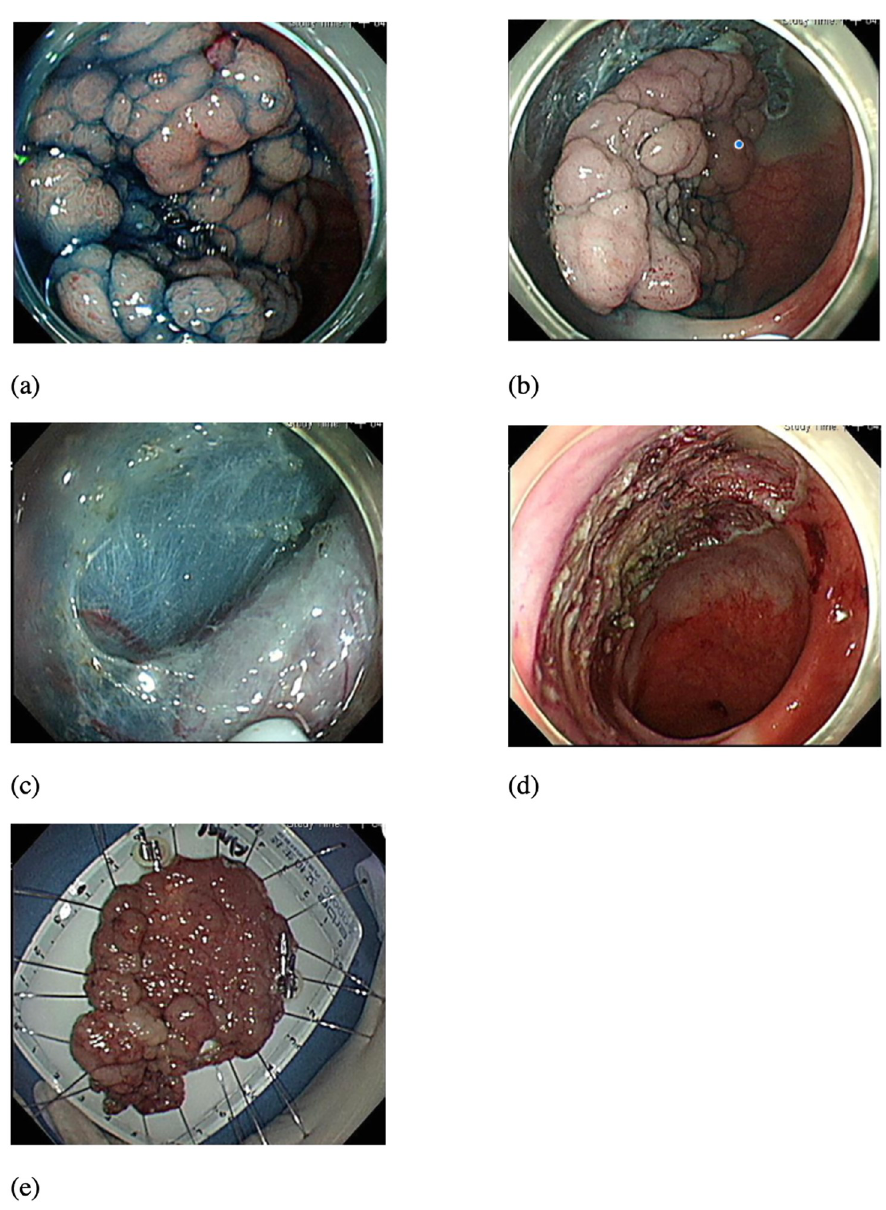
Fig 1. Colorectal ESD procedure. (a) Chromoendoscopy with indigo carmine staining (b) Circumferential cutting (c) Submucosal dissection (d) Complete resection (e) Specimen fixation. Therapeutic and histopathological results of ESD for colorectal neoplasms The ESD time was 51.9 ± 32.9 minutes (Table 2). Forty of 244 lesions (16.4%) were completed with hybrid ESD. Nine cases (3.7%) had procedure-related complications, including two mini- mal perforations (0.8%) closed by SureClip 1 successfully after the complete ESD procedure and 7 delayed bleeding (2.9%). Our minimal perforation was defined as muscle layer defect without observation of mesenteric fat or intra-peritoneum organ and pneumoperitoneum. All post-ESD bleeding ceased spontaneously after medical treatment and observation. There was